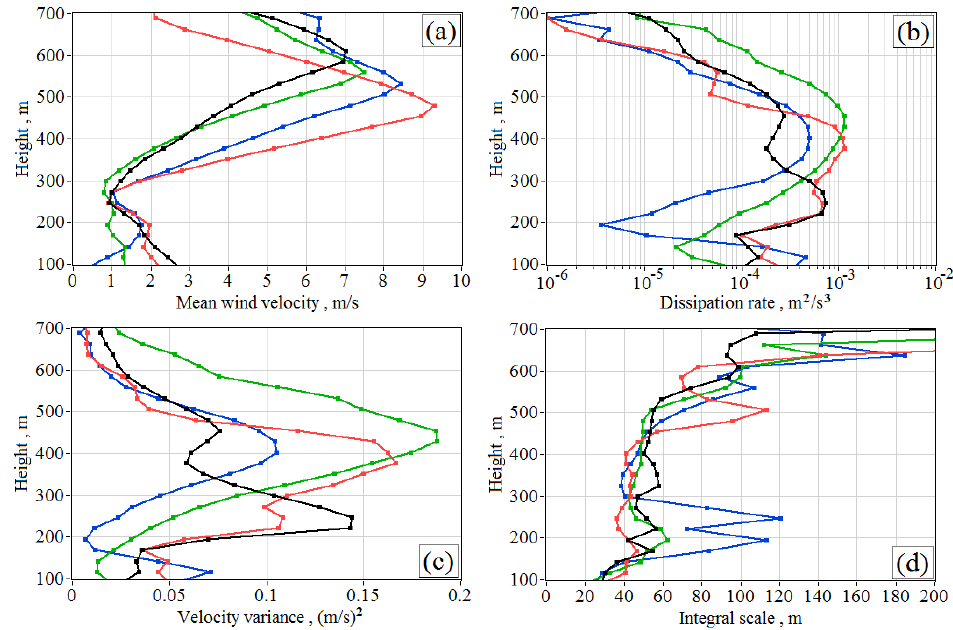
Figure 10. Vertical profiles of the mean wind velocity ( a ), turbulence energy dissipation rate ( b ), variance of turbulent fluctuations of the radial velocity ( c ), and integral scale of turbulence ( d ) retrieved from measurements by the StreamLine lidar at the Baikal coast on 02:00 (black curves), 04:00 (red curves), 06:00 (green curves), and 08:00 LT (blue curves) on 24 August